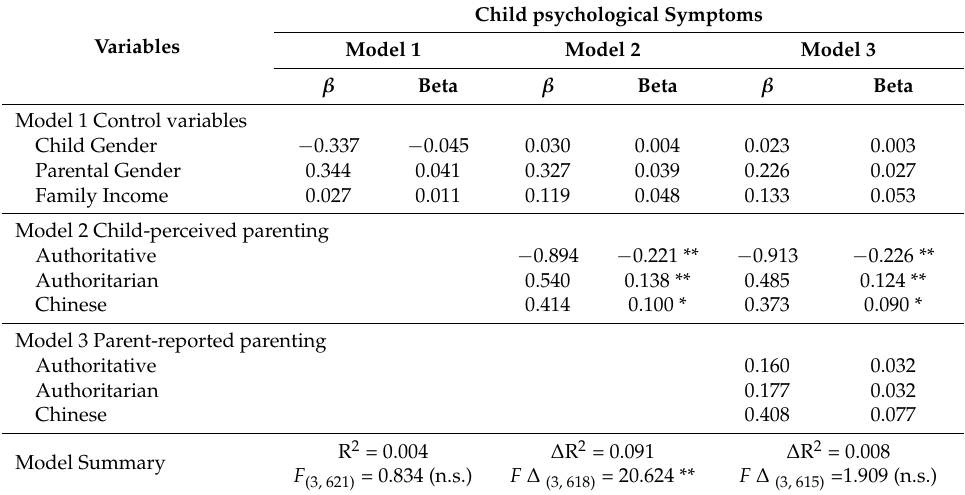
Table 5. Results of hierarchical multiple regressions predicting child psychological